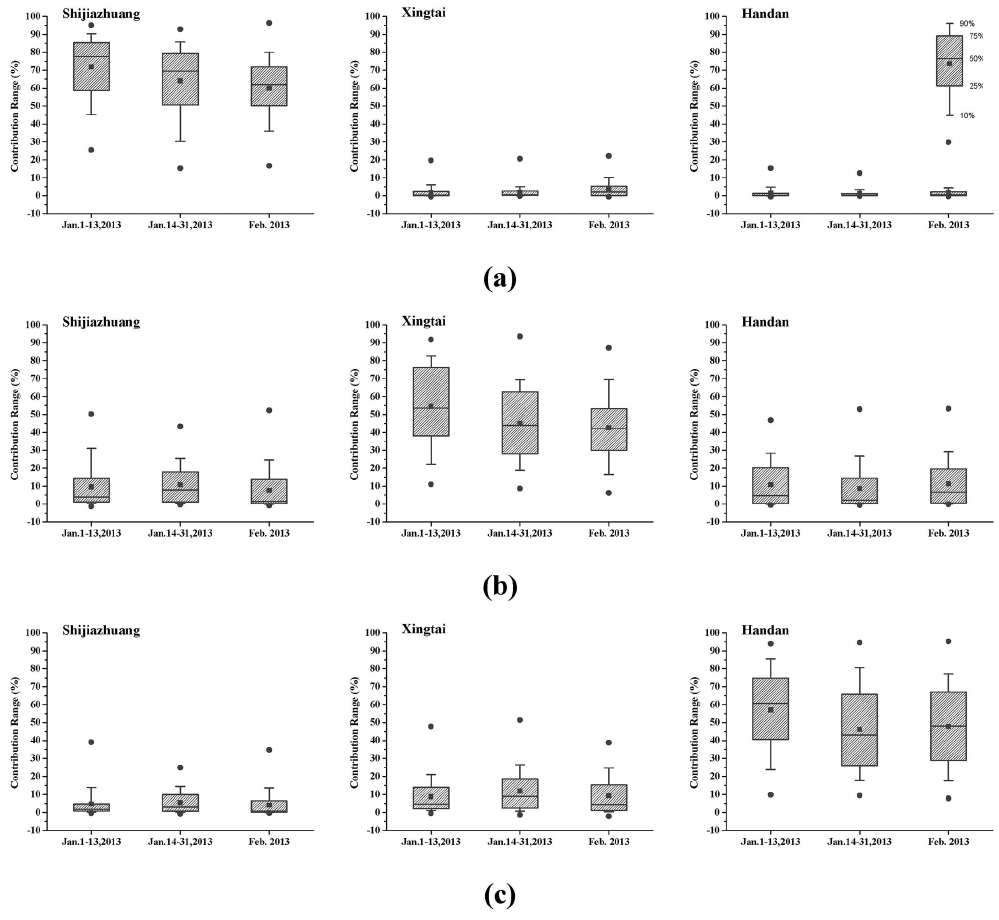
Fig. 10. The source contribution ranges by the three cities of Shijiazhuang, Xingtai, and Handan to (a) Shijiazhuang, (b) Xingtai, and (c) Handan in 1–13 and 14–31 January, and February, 2013. Dot signs indicate the maximum and minimum, and square signs indicate the average